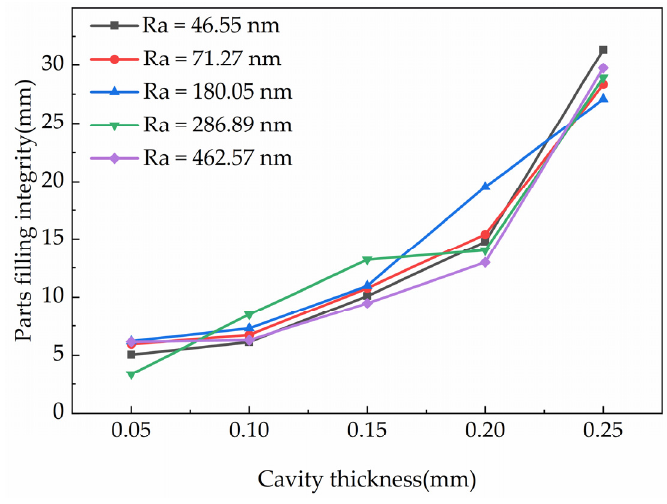
Figure 8. Parts filling integrity in cavities with different cavity thicknesses.